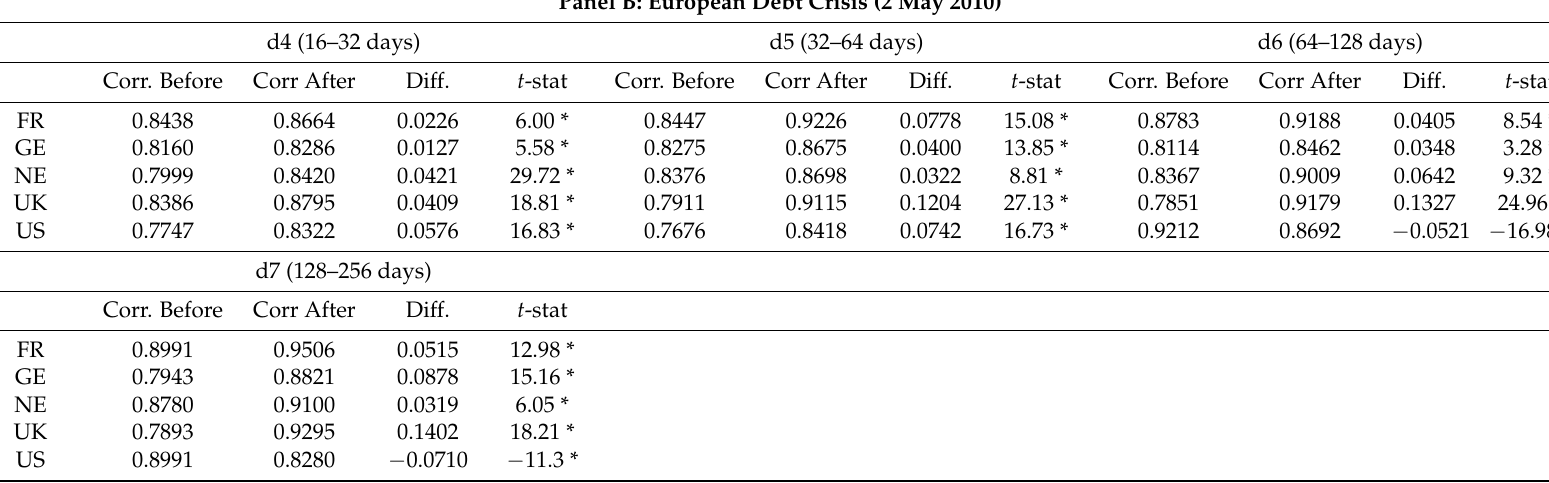
Panel B: European Debt Crisis (2 May